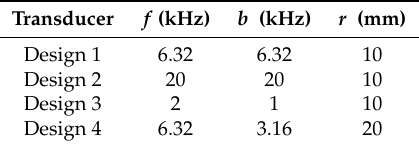
Table 2. Sets of excitation parameters under